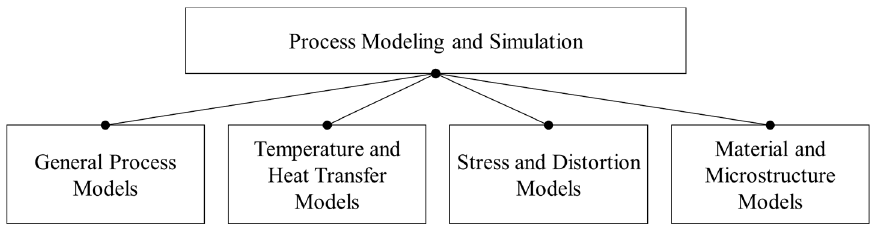
Figure 7. Process modeling and simulation categories.